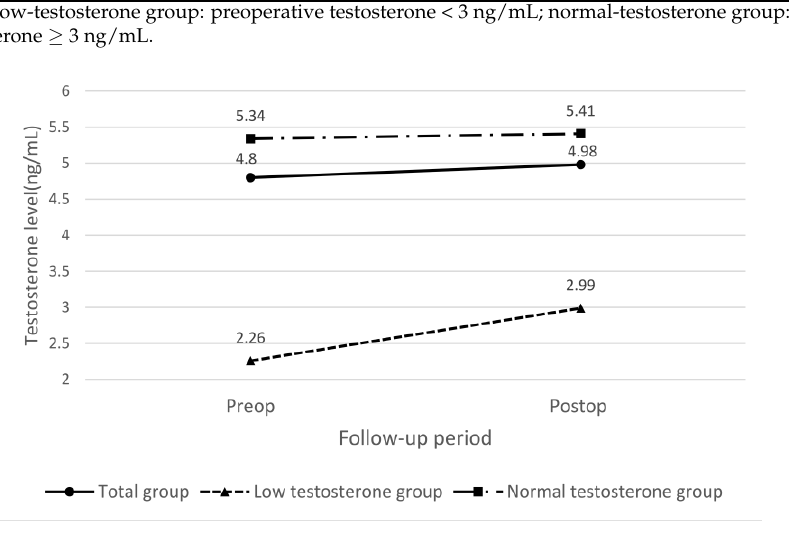
Figure 1. Preoperative and postoperative testosterone levels in the low- and normal-testosterone Figure 1. groups. Table 4. Comparison of the frequency of preoperative and postoperative nocturia episodes in the low- and normal-testosterone groups.